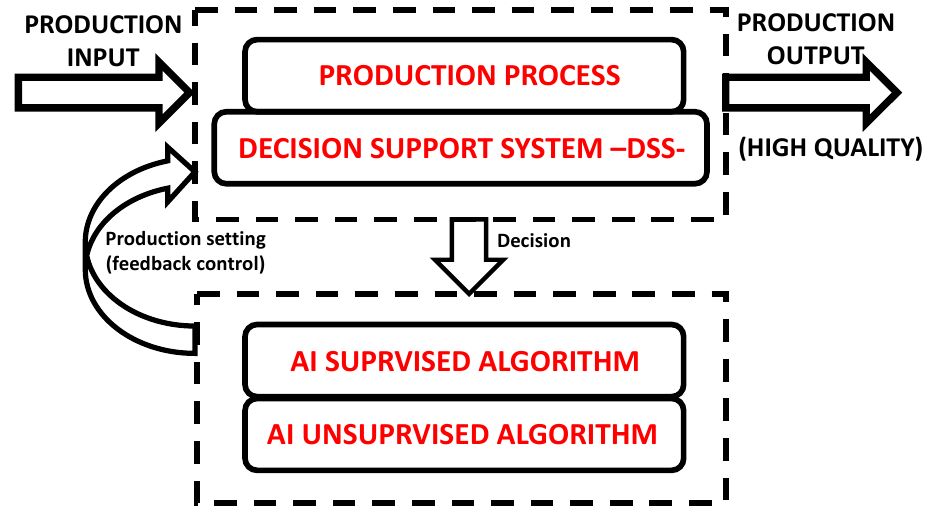
Figure 1. “ Proof of concept” of PM. Figure 1. “Proof of concept” of